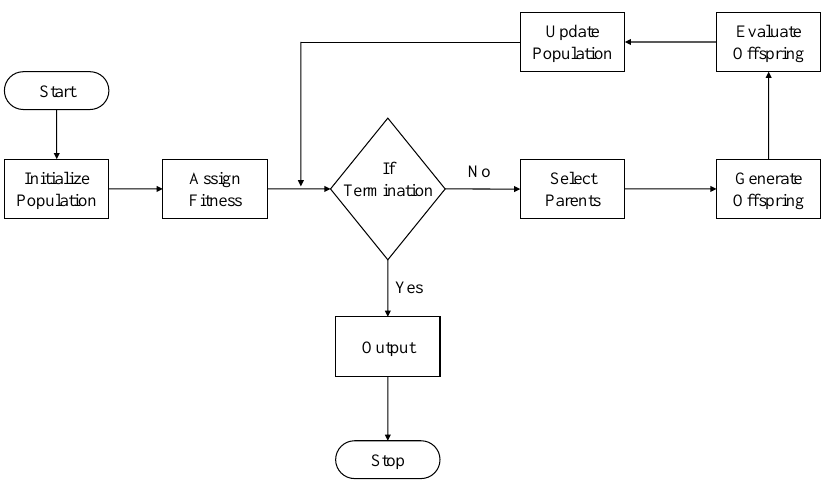
Figure 9. A flowchart for a general evolutionary